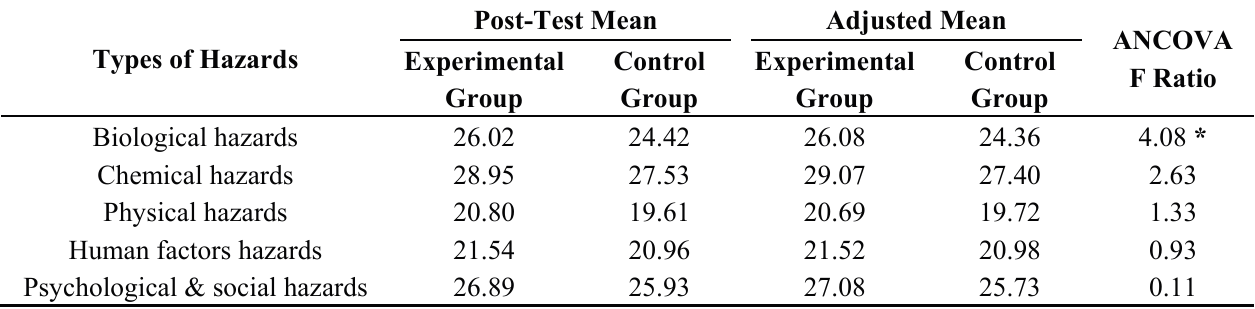
Table 5. Analysis of research subjects’ awareness toward prevention of occupational